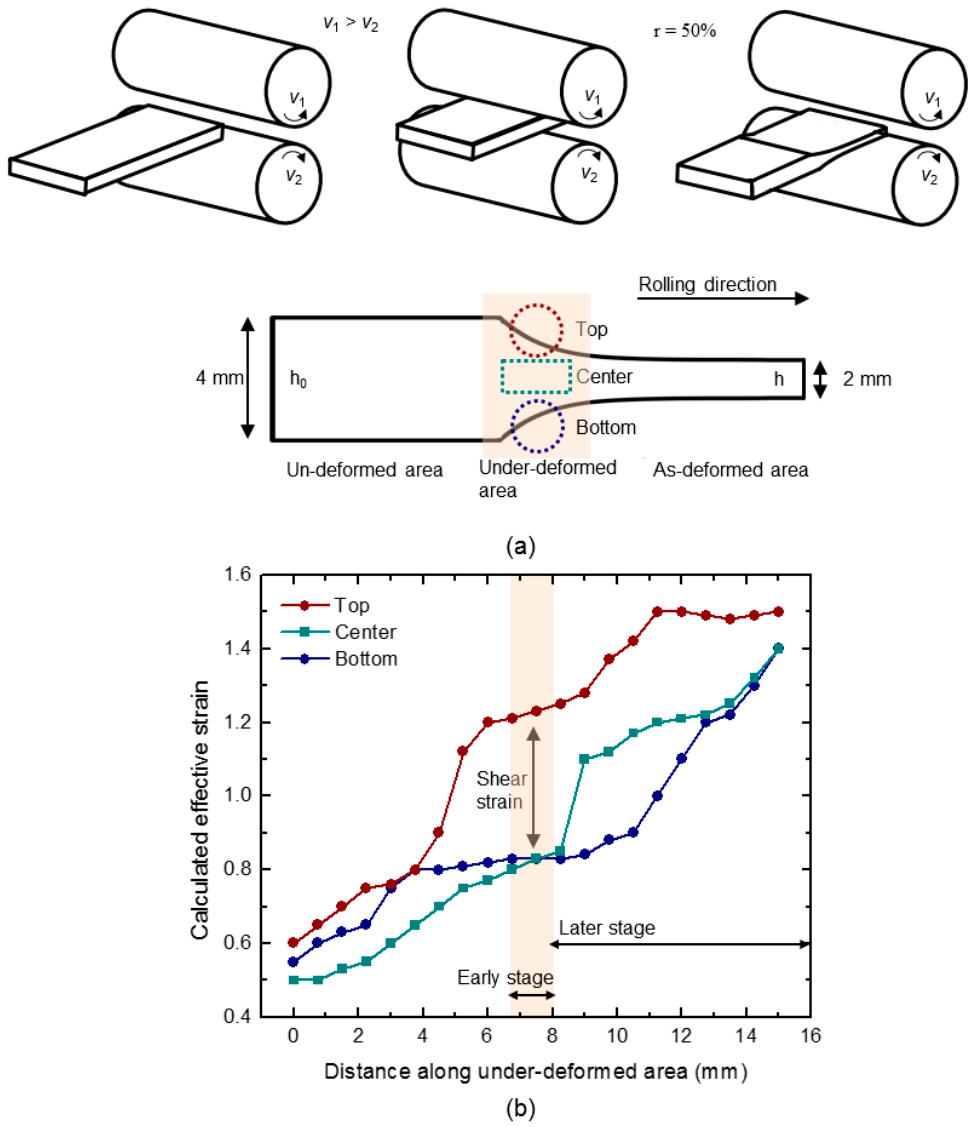
Figure 1. ( a ) Schematic illustrations of the asymmetrical rolling (AR) deformation of AZ31 Mg alloy from the left to the right and the cross section of the deformed sample that was stopped in the middle of AR and ( b ) a variation of calculated effective strain calculated by finite element analysis taken from [16]. The shaded area means the early stage of AR deformation by stopping.